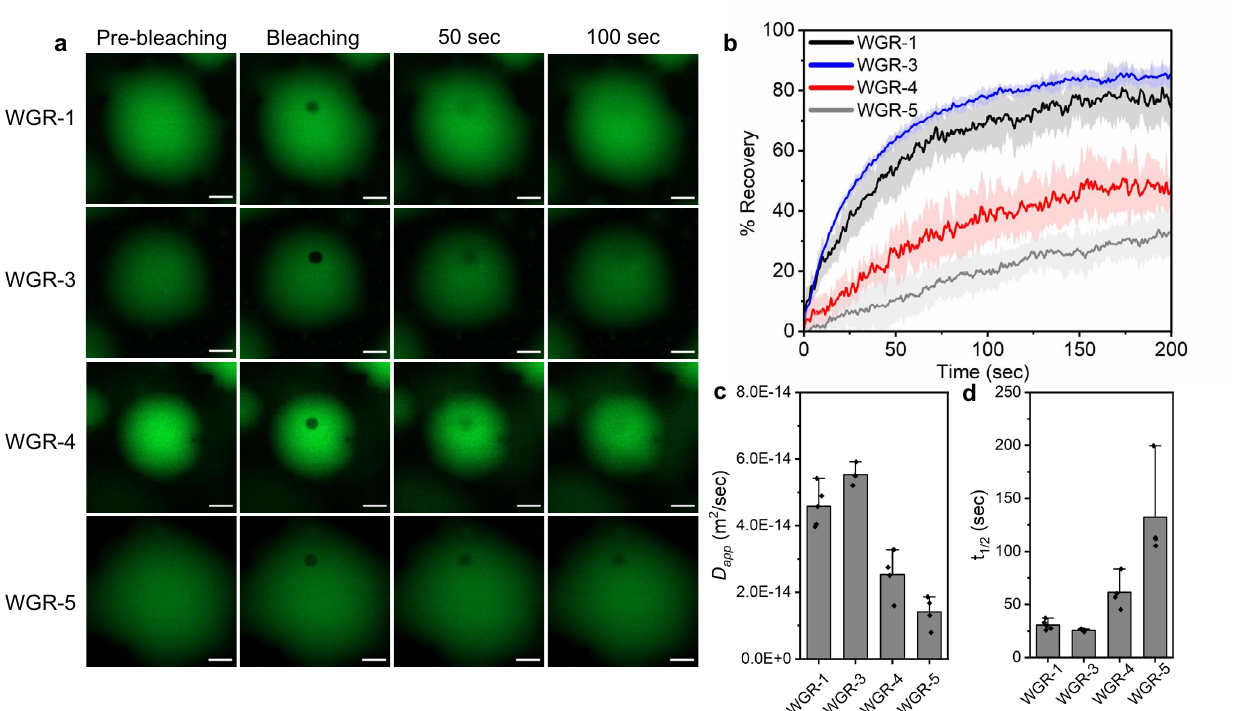
Fig. 3 | Strength of intermolecular interactions affects peptide droplet dynamics. a – c FRAP analysis of WGR-1, WGR-3, WGR-4, and WGR-5, performed usinglaserscanningconfocalmicroscopyat20mMinTrisbufferatpH8with0.2M NaCl using 0.5% FITC-labeled peptides. a Representative confocal microscopy